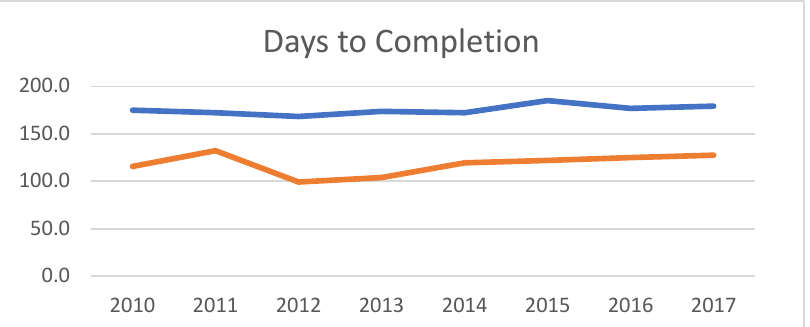
Figure 1. Time Series of Descriptive Statistics. The four panels of this figure compare the year-by-year descriptive statistics, as at the time of the merger and acquisition announcement, of the average capital ratios for banks (defined as Tier 1 capital ratio) and non-banks (defined as shareholder equity over total assets); the average transaction value (in millions), the average takeover premium in percentage compared to the stock price one week before the announcement; and the average number of days from the announcement to completion of the acquisition. Plots in red are for non-banks, and those in blue are for banks.